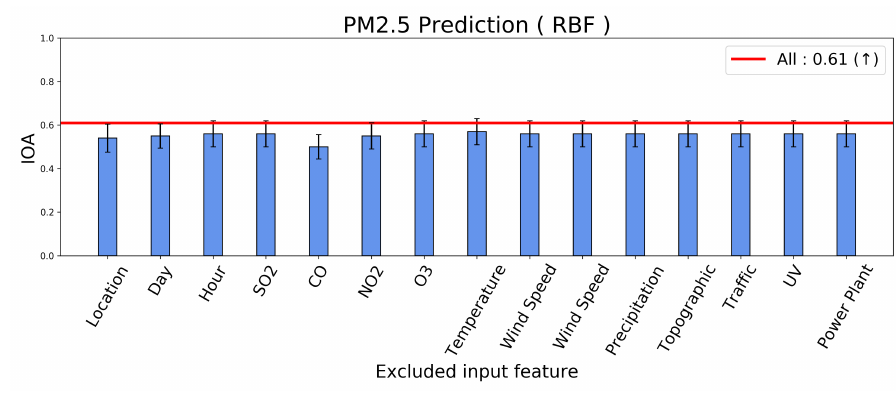
Figure 8. Ablation study for the input features in the prediction of